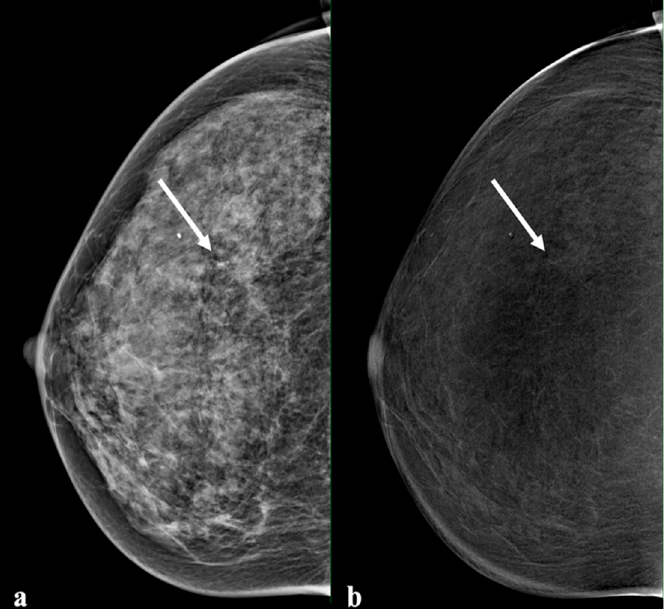
Figure 3. Example of a lesion with marked enhancement (Grade 3). A 71-year-old patient with a spiculated lesion in the outer quadrant of the right breast. Histology showed an invasive cancer. Mammography (( a ), low energy) showed a dense, irregular, and spiculated mass (arrow). ( b ) The recombined image ( b ) showed minimal background parenchymal enhancement and a mass with a marked rim enhancement (arrow).